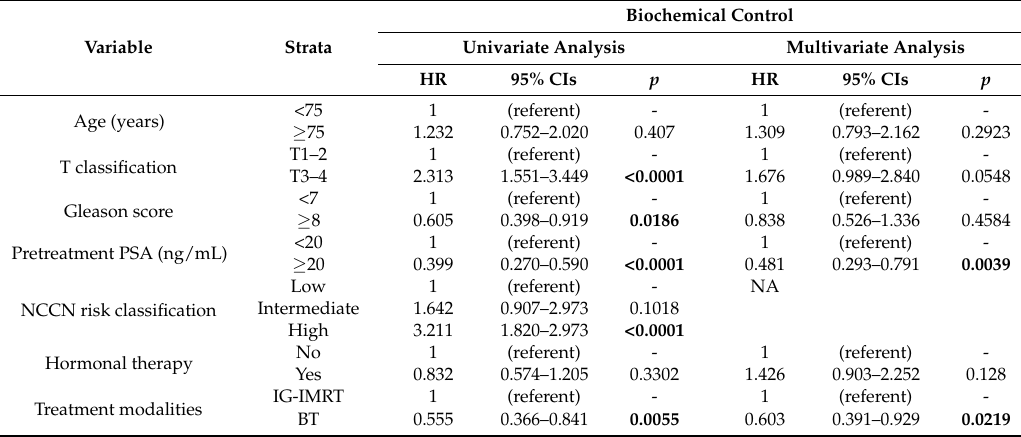
Table 2. Univariate and multivariate analysis for biochemical control rate using Cox proportional hazards model.